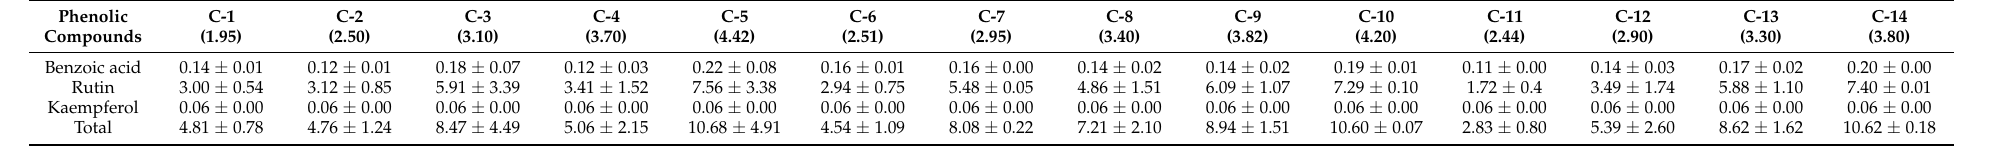
Table 6. Concentration range of values obtained through the second HPLC reference analysis for moringa